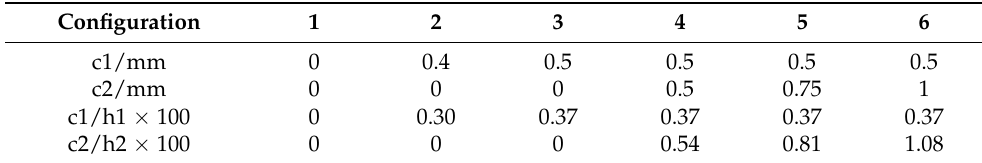
Figure 6. The computational mesh of compressor with seal cavity leakage. Table 2. Clearance values for the different configurations. Table 2. Clearance values for the different configurations.